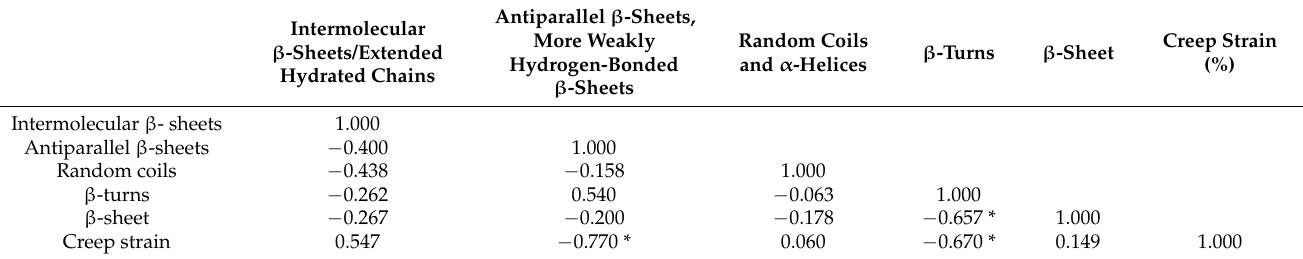
Table 2. Pearson correlation coefficients between different secondary structures of hydrated gluten and the extracted gluten viscoelastic property (creep